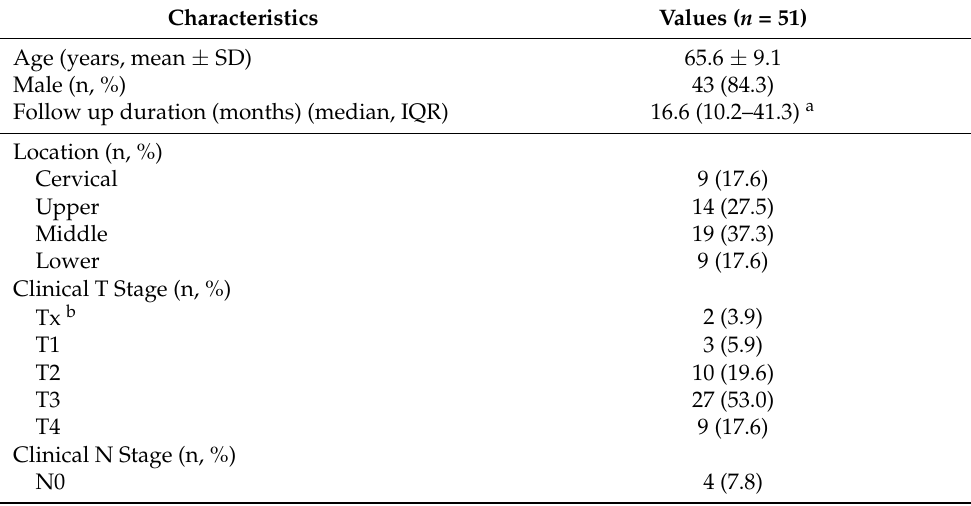
Table 1. Baseline characteristics of the patients with esophageal squamous cell carcinoma receiving definitive